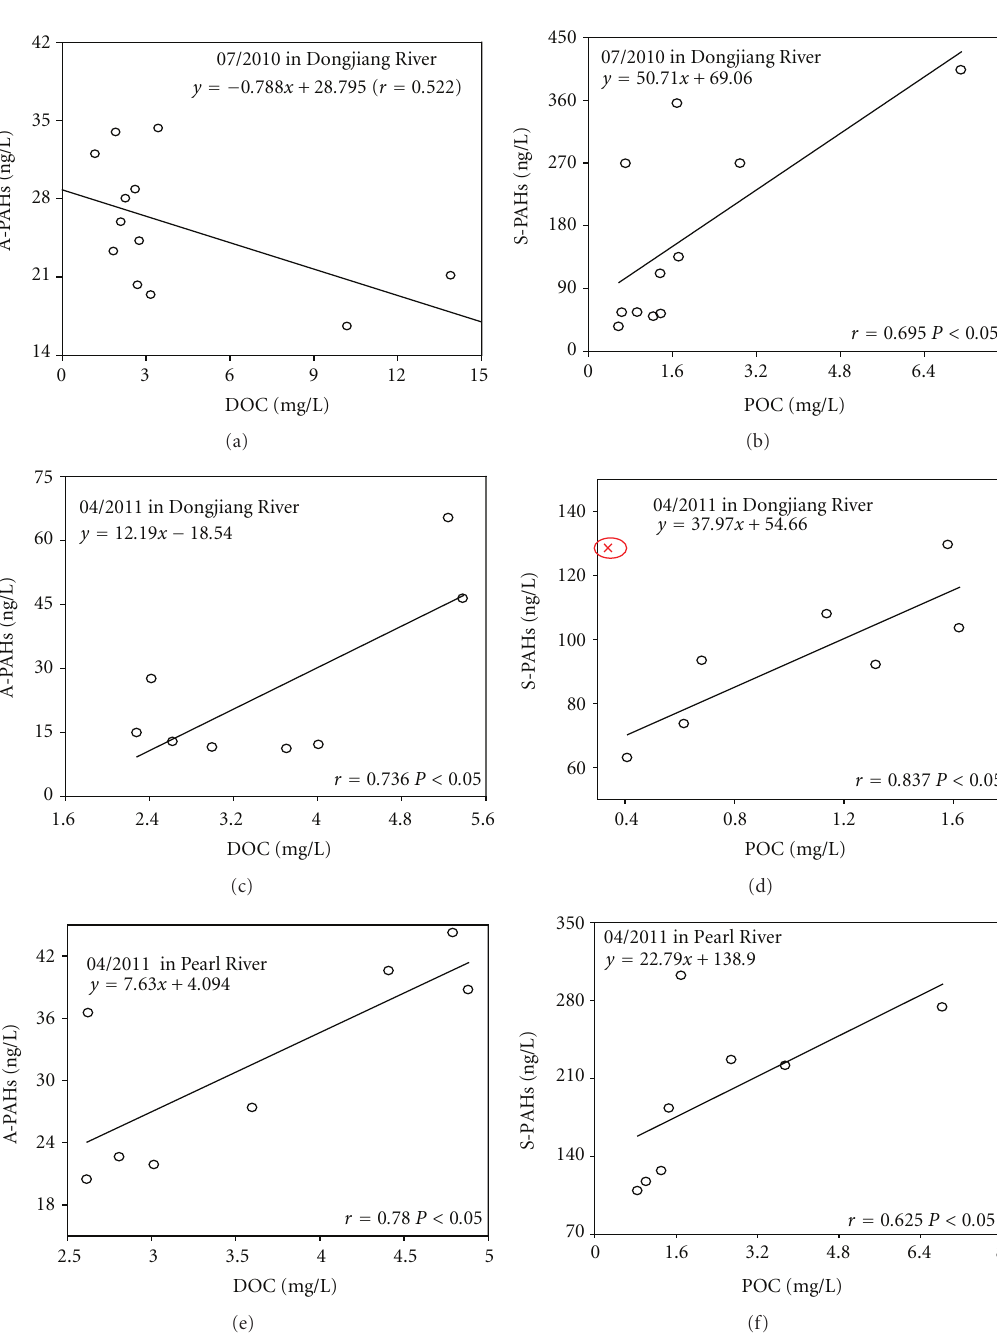
Figure 7: Correlations of 14 PAHs with DOC in water samples and with POC in the SPM samples. A-PAHs and S-PAHs correspond to the dissolved PAHs and particulate PAHs,